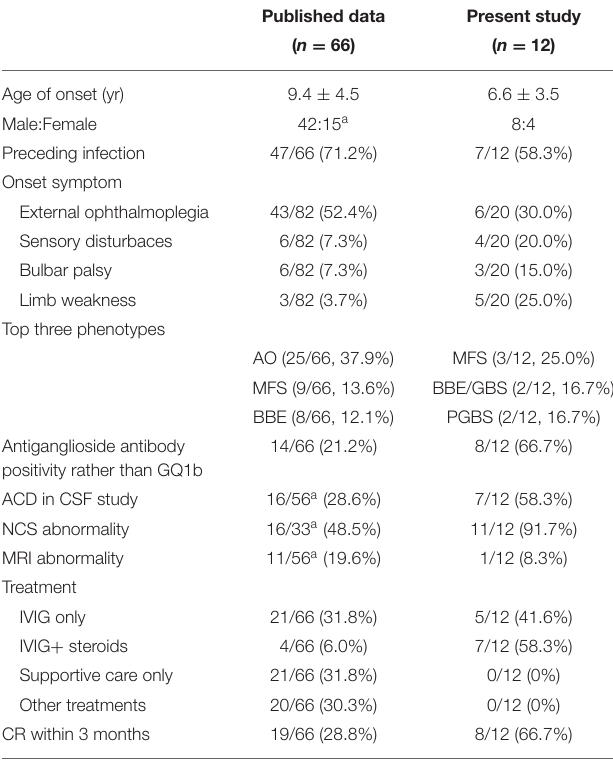
TABLE 2 | Clinical features of unpublished cases and previously reported childhood